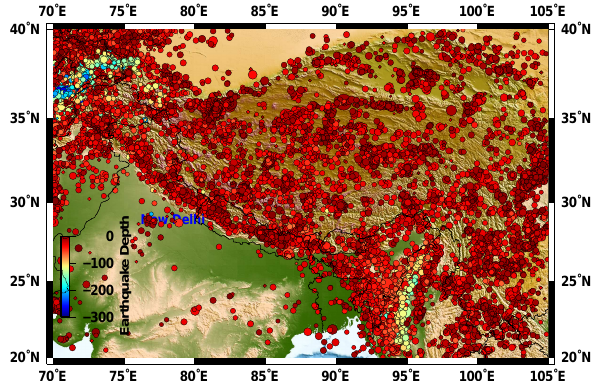
Figure 5. Selected region for Experiment 4